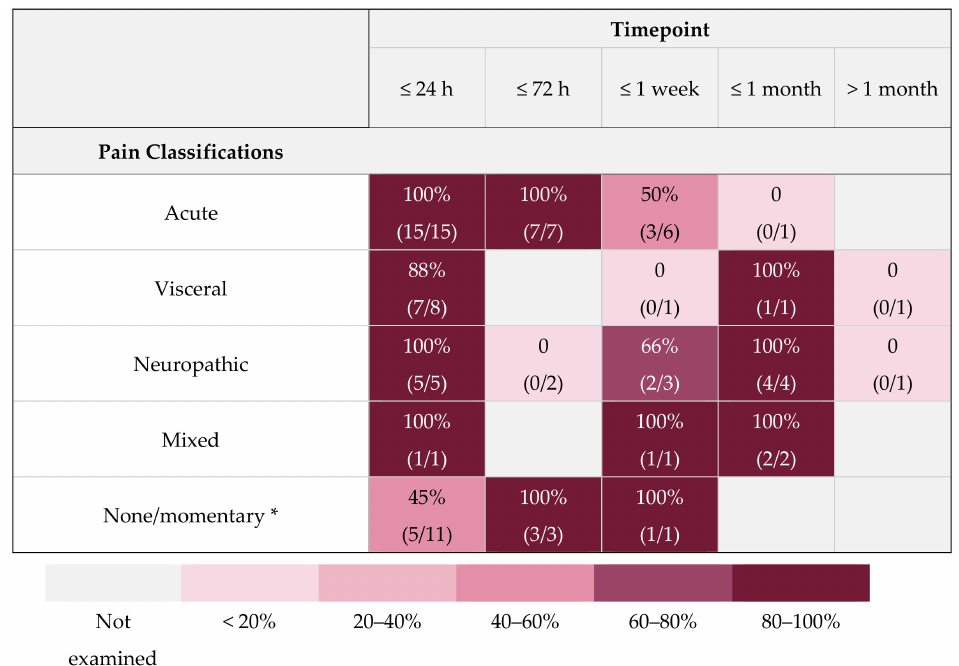
Figure 9. Heat map contrasting type of pain expected to arise from the interventions with the time points after the intervention investigated. Colouration gradation represents percentage of studies where grimace scores moved in the expected direction of effect, with increased shading indicating a greater number of investigations—for example, 100% of studies evaluating procedures likely to cause acute pain showed increased MGS scores within the 24 h after the intervention. * Consider that no change in MGS score is